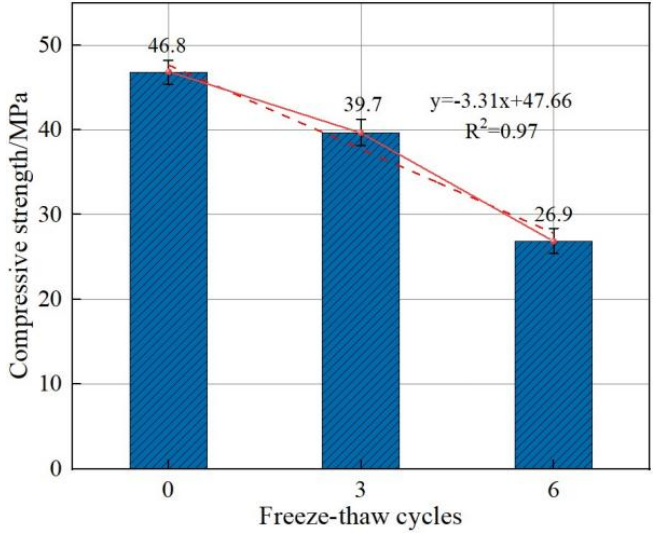
Figure 7. Effect of number of freeze–thaw cycles on the compressive strength of BFRC at ultra-low temperatures.